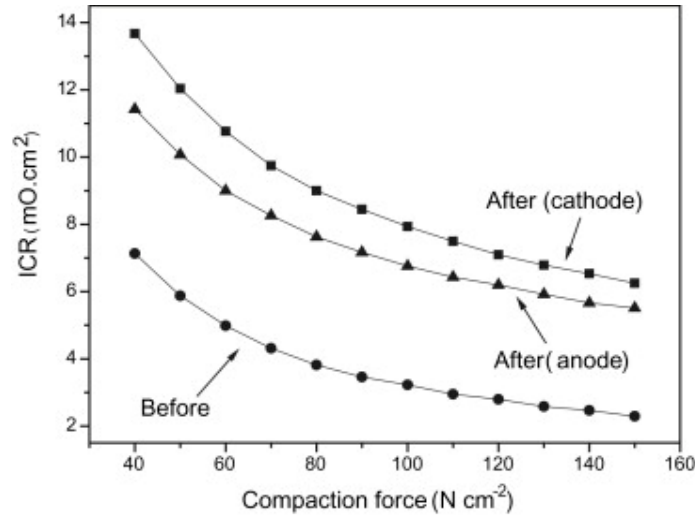
Figure 8. Contact resistance dependence on contact force. Reprinted from [45] copyright (2010), with permission from Elsevier.